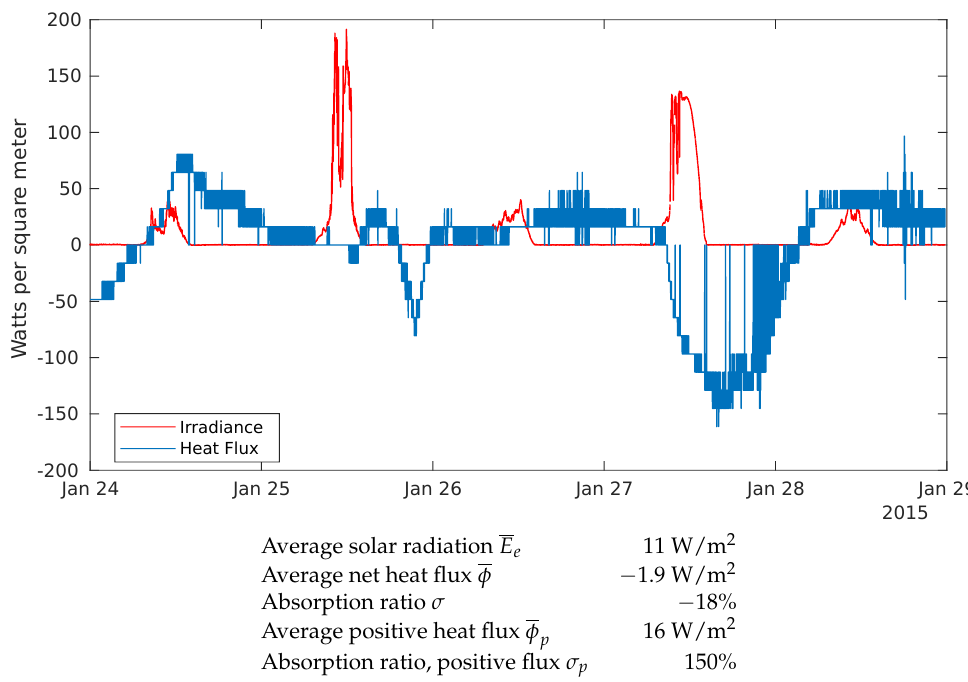
Figure 8. Instantaneous solar irradiation [W/m 2 ] and heat flux [W/m 2 ] from 24 to 29 Jan 2015 (winter), and their estimated average values as a function of time (day). Both irradiance and heat flux are negligible and heat flux is more dependent on the temperature than